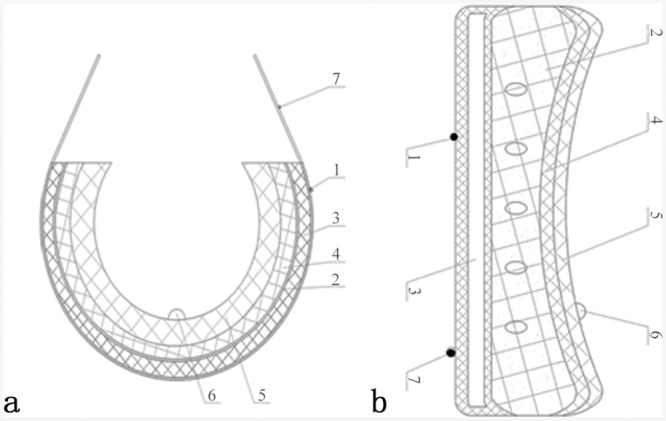
Designed sketch of SHSD.No. 1 and 7 show the fixed belts, No.2 shows the water bag, No. 3 shows the electric heating pad, No. 4 shows the protective layer of the water bag, No. 5 shows the thermal insulation layer and No. 6 shows the temperature probe which links with a digital display. (a) vertical section map of SHSD, (b) cross-section map of SHSD.